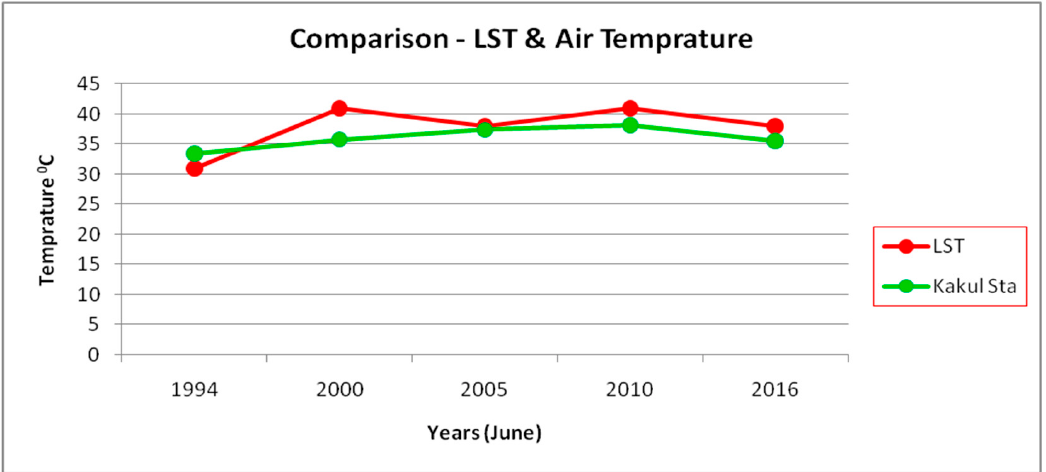
Figure 16. Comparison—LST and air temperature—Jun 1994–2016.